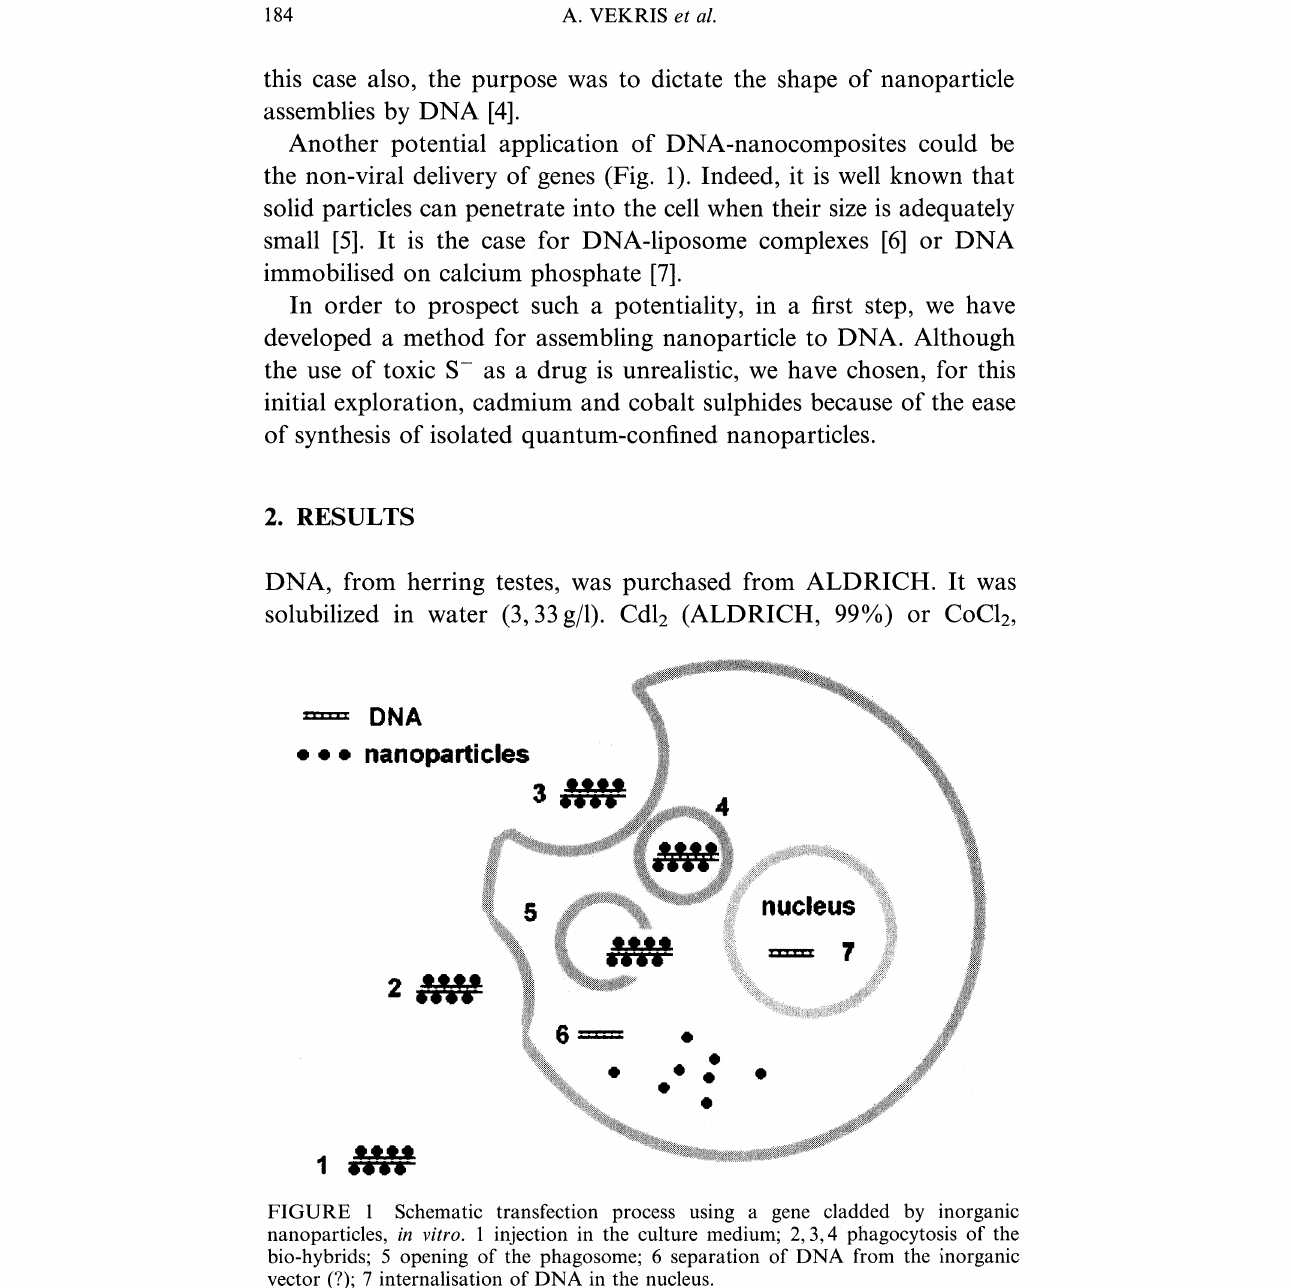
FIGURE Schematic transfection process using a gene cladded by inorganic nanoparticles, in vitro. injection in the culture medium; 2, 3, 4 phagocytosis of the bio-hybrids; 5 opening of the phagosome; 6 separation of DNA from the inorganic vector (?); 7 internalisation of DNA in the